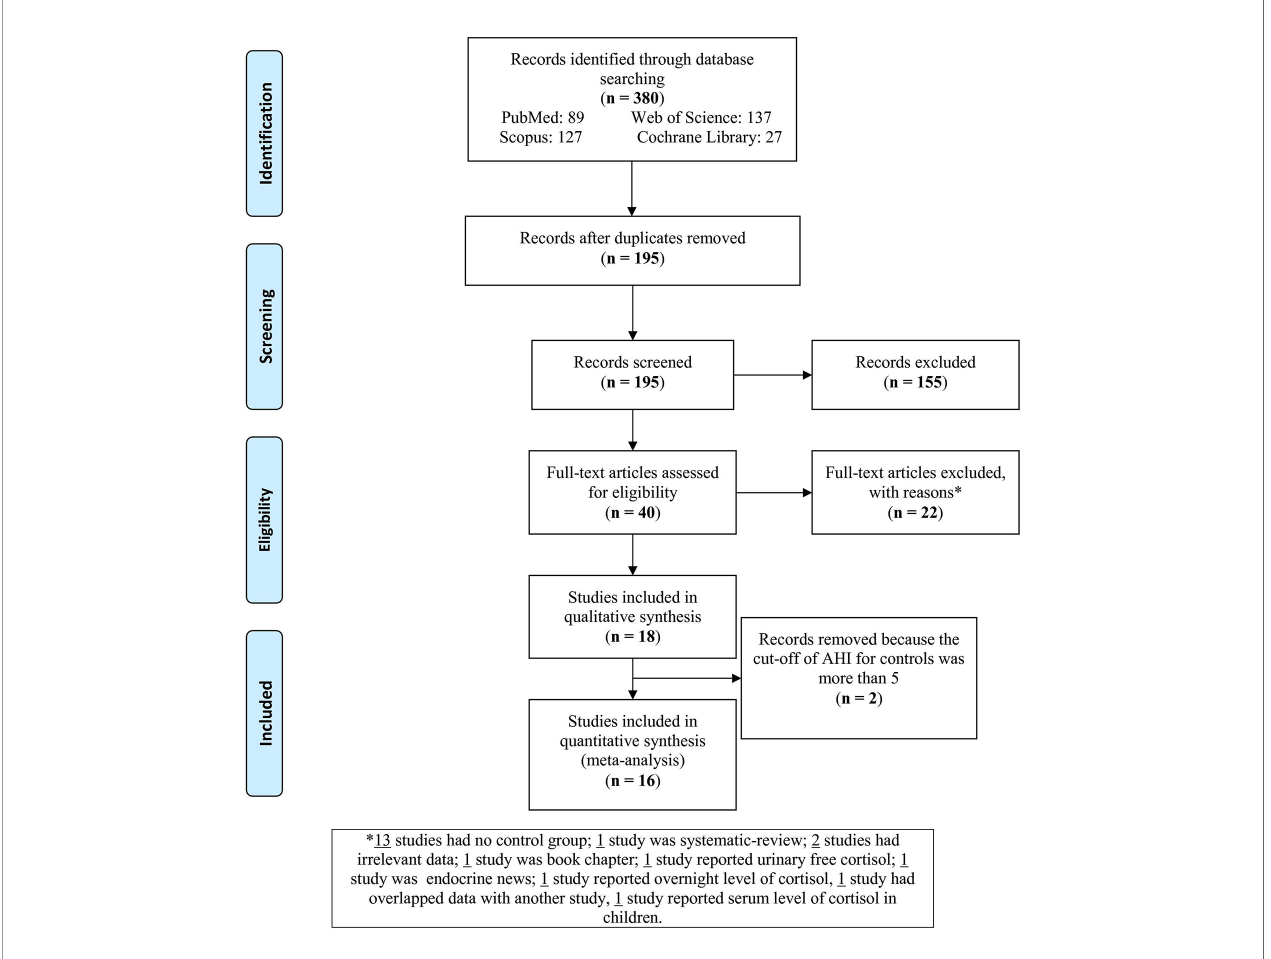
FIGURE 1 | Flow chart of the study